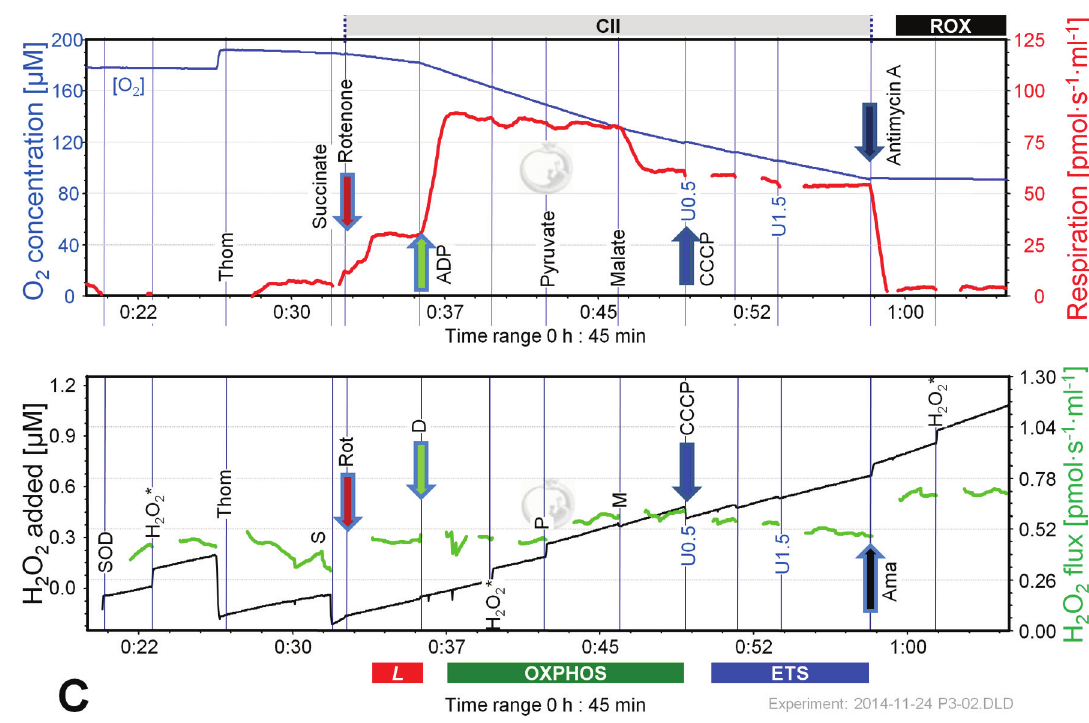
Figure 6. Combined determination of oxygen consumption and H 2 O 2 flux by O2k-Fluorometry in mouse brain homogenate, using PM ( A ); S ( B ); or S(Rot) as initial substrate ( C ). For details see legend of Figure 3. Carrier denotes ethanol (1 μL), which served as the solvent for rotenone and was titrated in parallel to